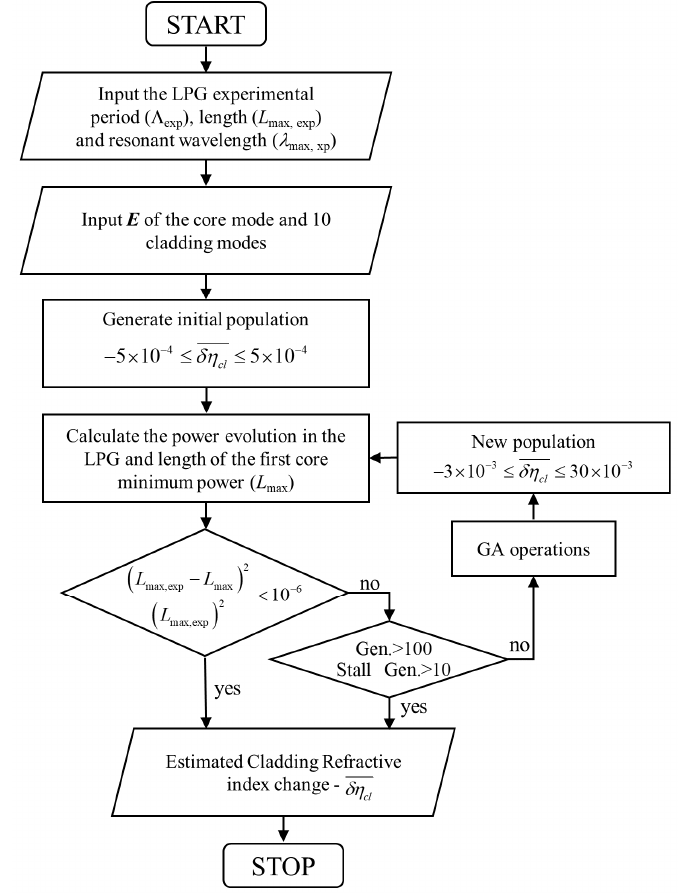
Figure 5. Flow chart of the GA implemented for the refractive index change estimation. Table 2. Estimated refractive index change obtained with the genetic algorithm (GA).